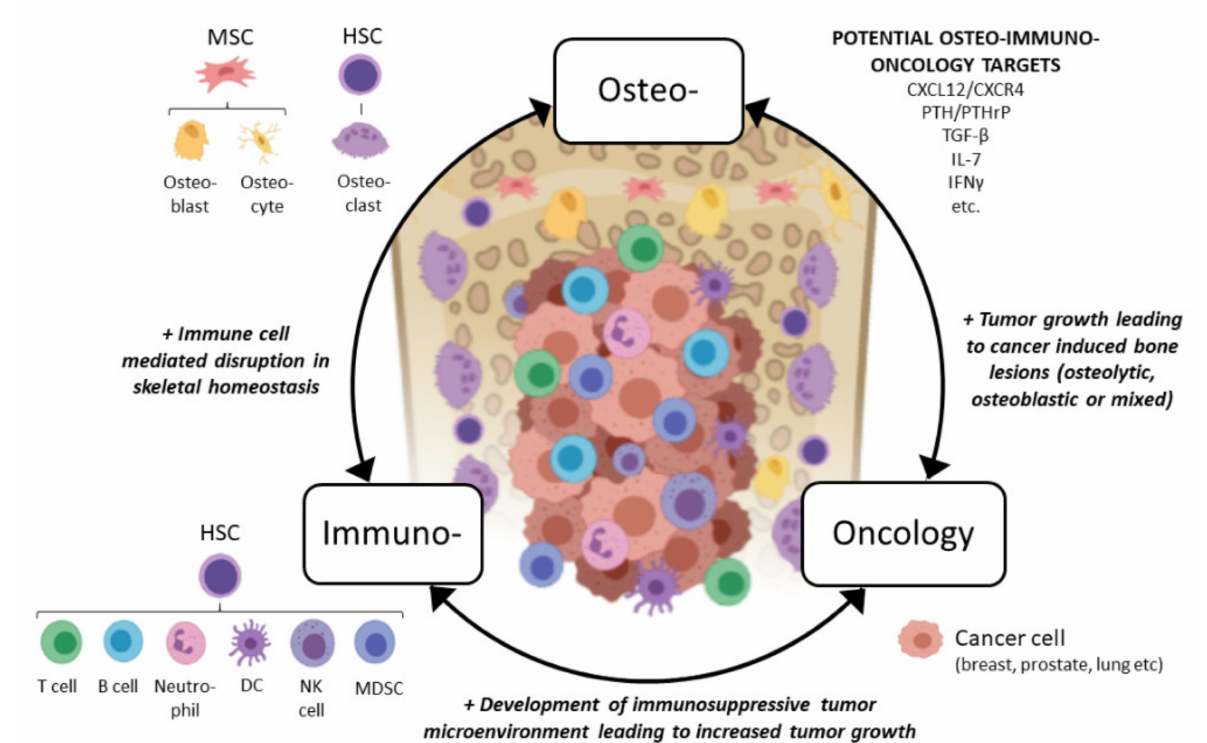
Figure 1. Concept of osteoimmuno-oncology and emerging potential targets for patients with bone metastases. Ab- breviations: MSC: mesenchymal stem cell, HSC: hematopoietic stem cell, DC: dendritic cell, NK: natural killer, MDSC: myeloid-derived suppressor cell, CXCL12: CXC chemokine ligand 12, CXCR4: CXC chemokine receptor type 4, PTH: parathyroidhormone, PTHrP: PTH-related peptide, TGF- β : transforming growth factor beta, IL-7: interleukin 7, IFN- γ : interferon gamma. Figure created with